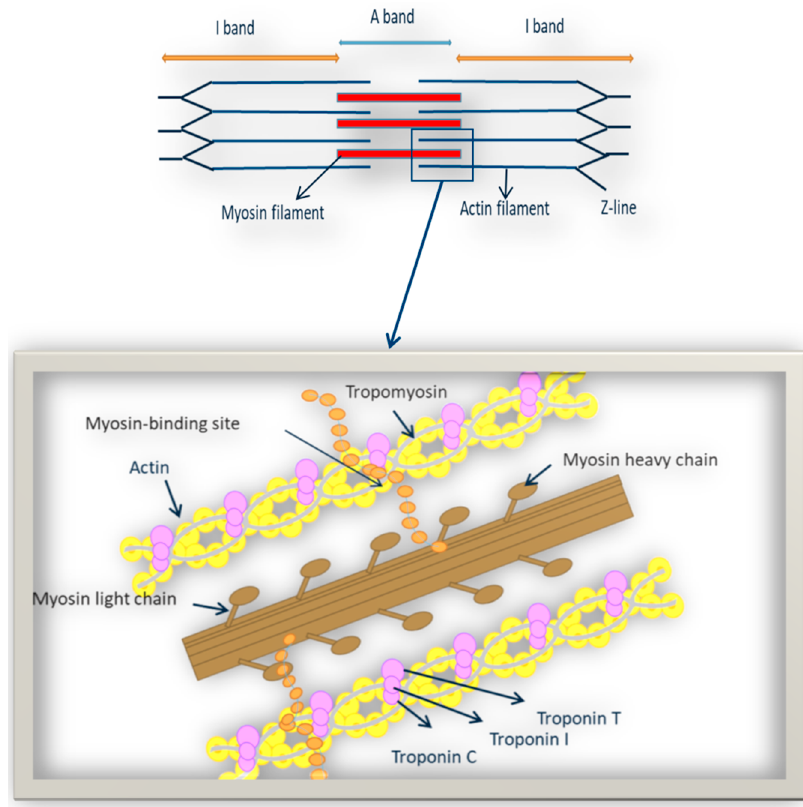
Figure 2. Representation of sarcomeric proteins responsible for expression of HCM. Table 1. List of genes implicated in hypertrophic